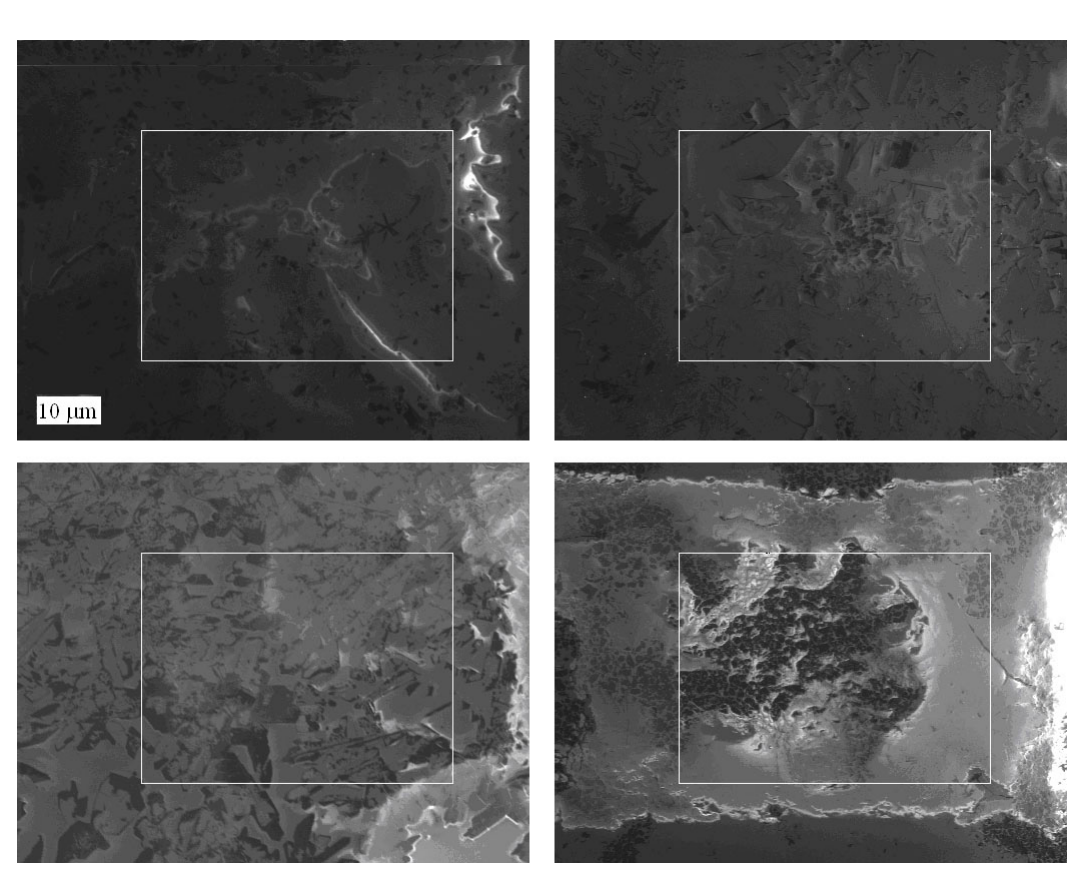
Figure 12. Scanning electron micrographs of glazes obtained using sol-gel-derived pigments: CoAl